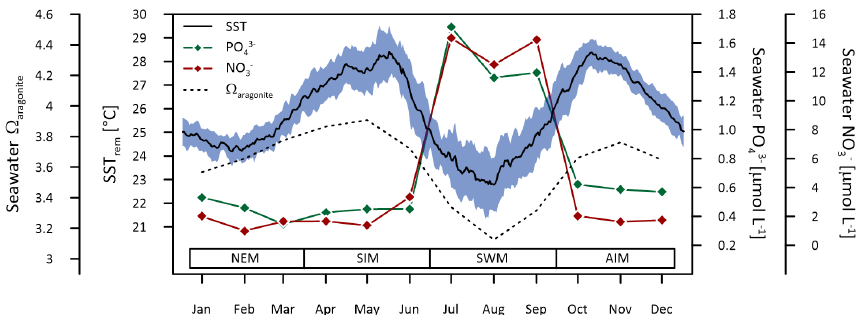
Figure 2. Ocean climatological data estimated from daily SSTs (JPL MUR MEaSUREs Project, 2015), monthly seawater phosphate (PO 3 − and nitrate (NO − ) concentrations (WOA18; Garcia et al., 2019), and aragonite saturation state ( (cid:127) aragonite ) (Takahashi et al., 2014) at the 3 sampling site. The blue shaded area represents the deviation (1 σ ) from averages of daily SSTs within the period 2003–2018. Seasonal abbreviations: NEM (northeast monsoon), SIM (spring intermonsoon), SWM (southwest monsoon), AIM (autumn